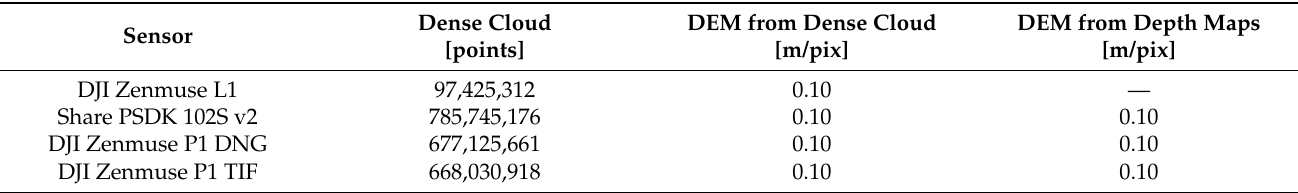
Table 6. List of generated semi-finished products for further analysis and data processing. Dense Sensor